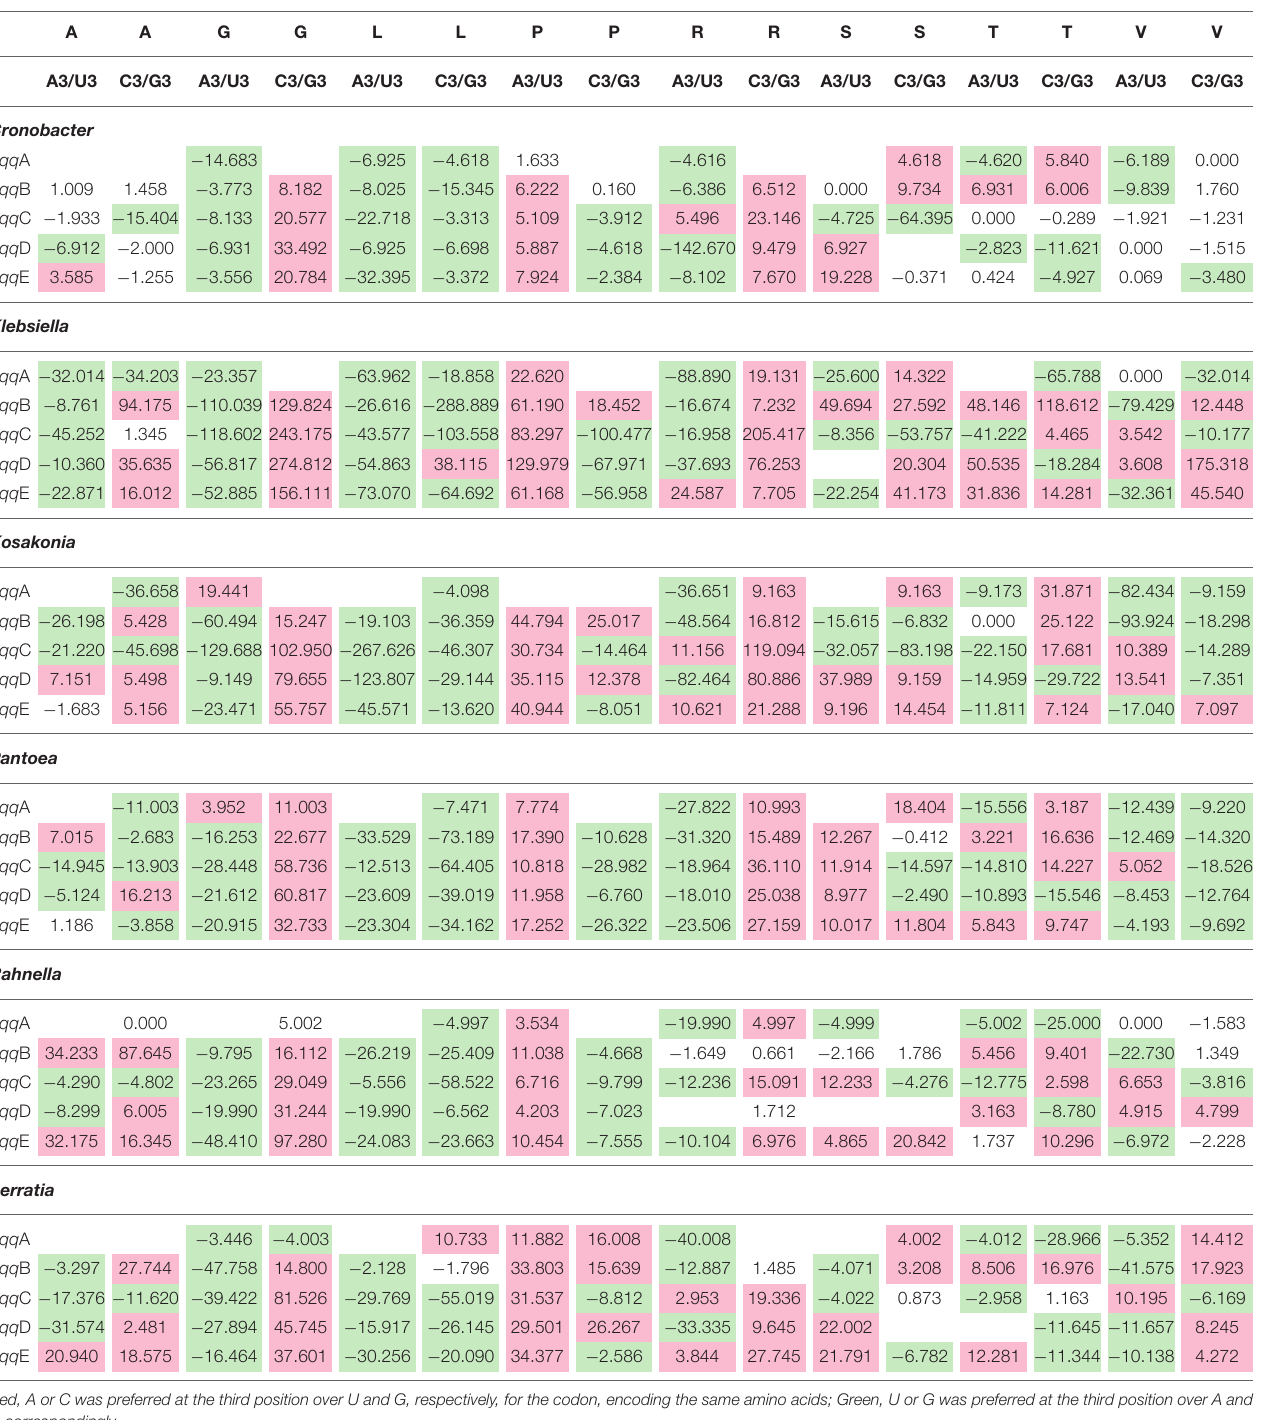
TABLE 3 | T -tests of the RSCU values of synonymous codons for Gammaproteobacteria pqqA , pqqB , pqqC , pqqD , and pqqE genes, at 5% level of significance ( p <